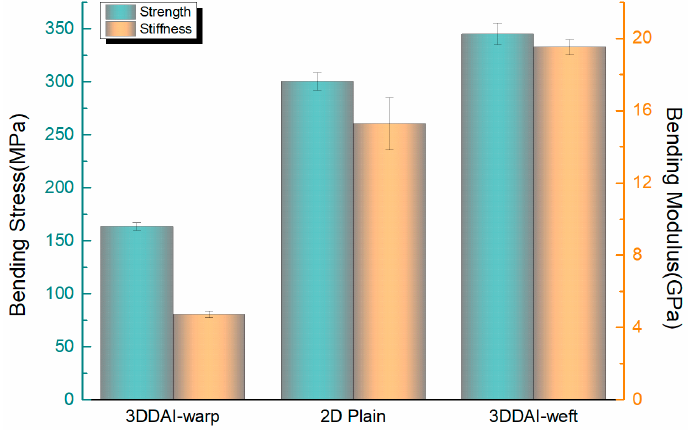
Figure 13. Comparison of the bending properties of the 3DDAI Kevlar/EP armor material and the 2D plain laminated Kevlar/EP armor material.